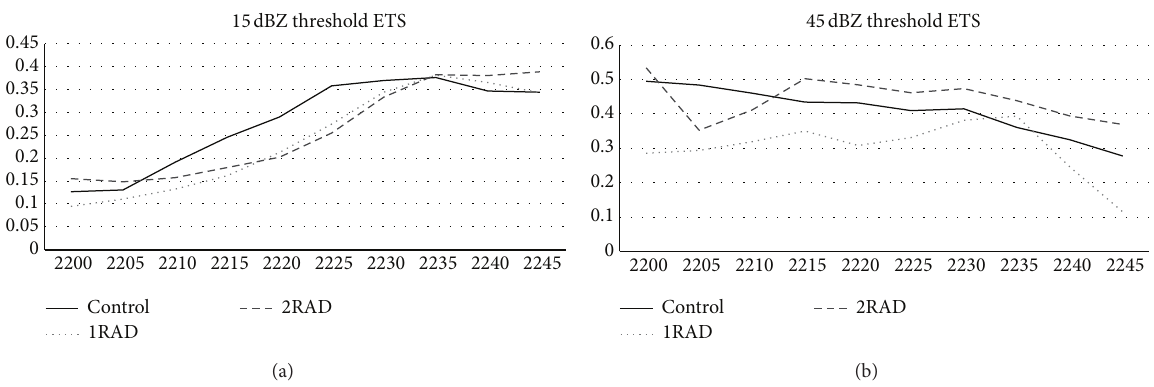
Figure 13: Equitable threat scores (ETS) of predicted radar reflectivity for (a) 15 and (b) 45dBZ validated using KTLX radar composite